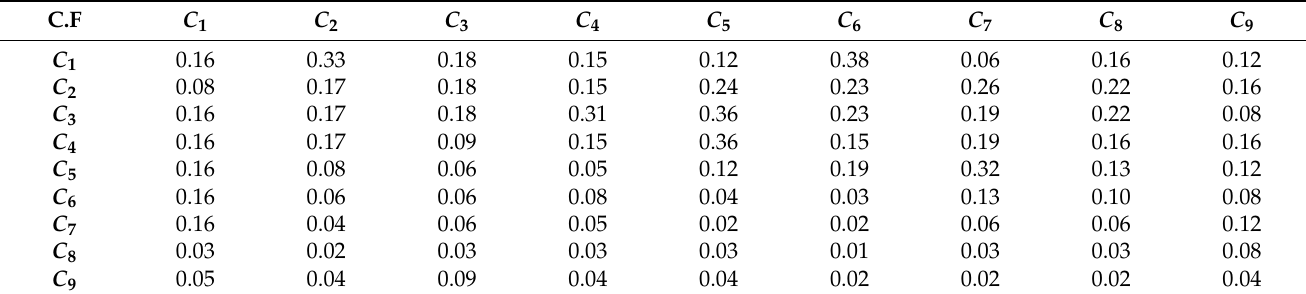
Table 4. Consistency matrix.